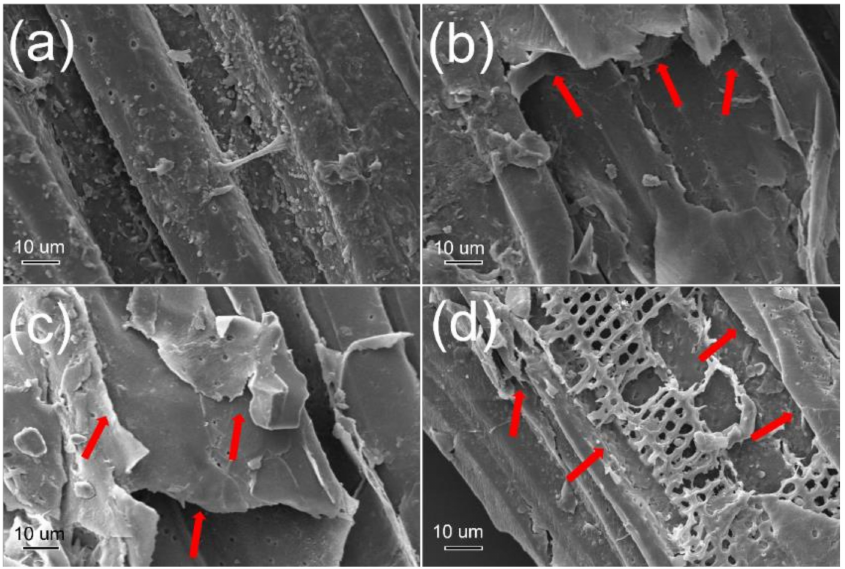
Figure 2. SEM images of the raw material and thread rolling treated fibers (( a ) Raw materials; ( b ) 20–40 mesh enzymatic residue; ( c ) 40–60 mesh enzymatic residue; ( d ) 60–80 mesh enzymatic